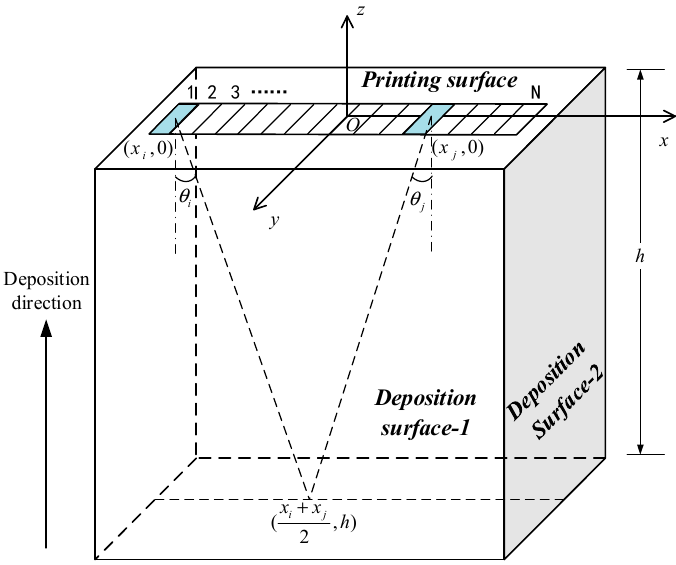
Figure 4. The principle of group velocity measurement based on the full matrix capture method.